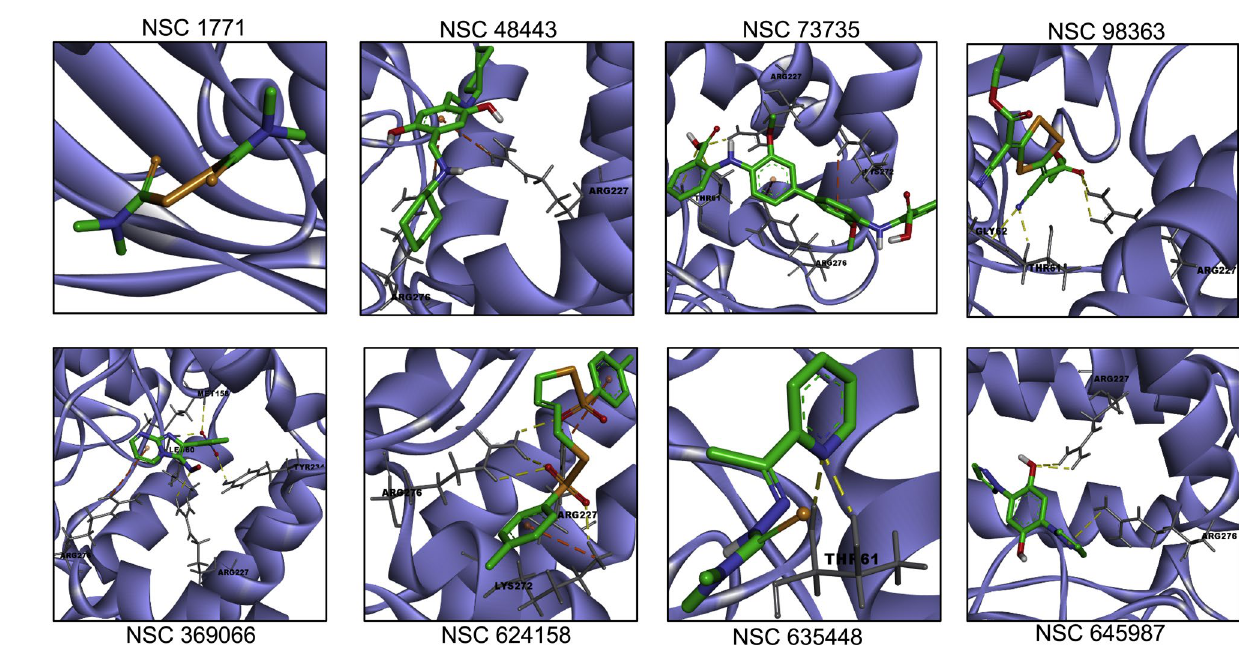
Figure 5. Molecular docking of the identified primary hits in MetX structure from M. tuberculosis . Docking of the identified primary hits in the three-dimensional structure of Rv3341 is shown. The hydrogen bonds and cation-pi bonds have been shown as yellow dotted and orange dotted lines, respectively. The residues involved in these interactions are also labeled in the